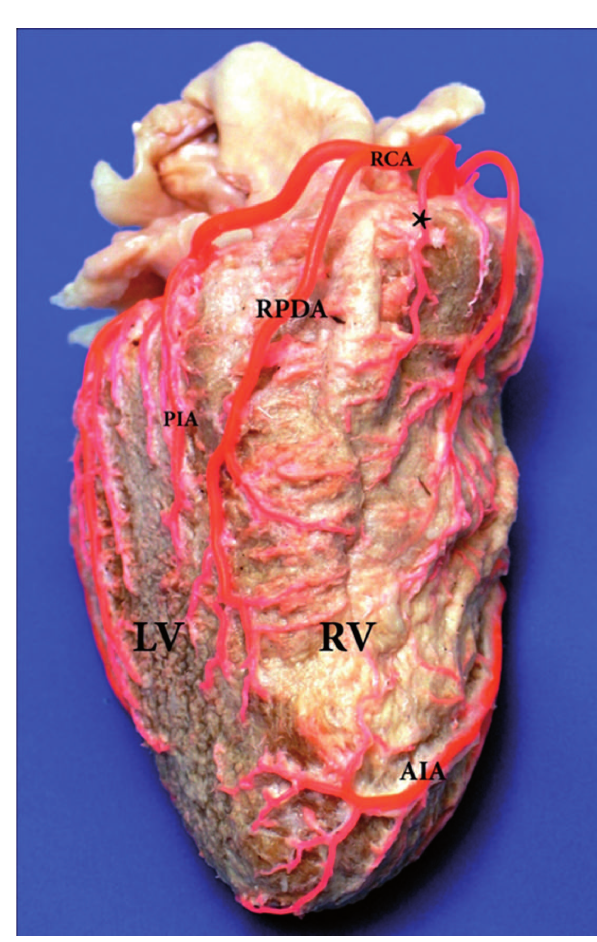
Fig. 5 - Posterior view and acute margin of the heart. Right marginal artery (*). RDPA: Right posterior diagonal artery. RV: right ventricle. LV: Left ventricule. PIA: Posterior interventricular artery. AIA: Anterior interventricular artery. RCA: Right coronary